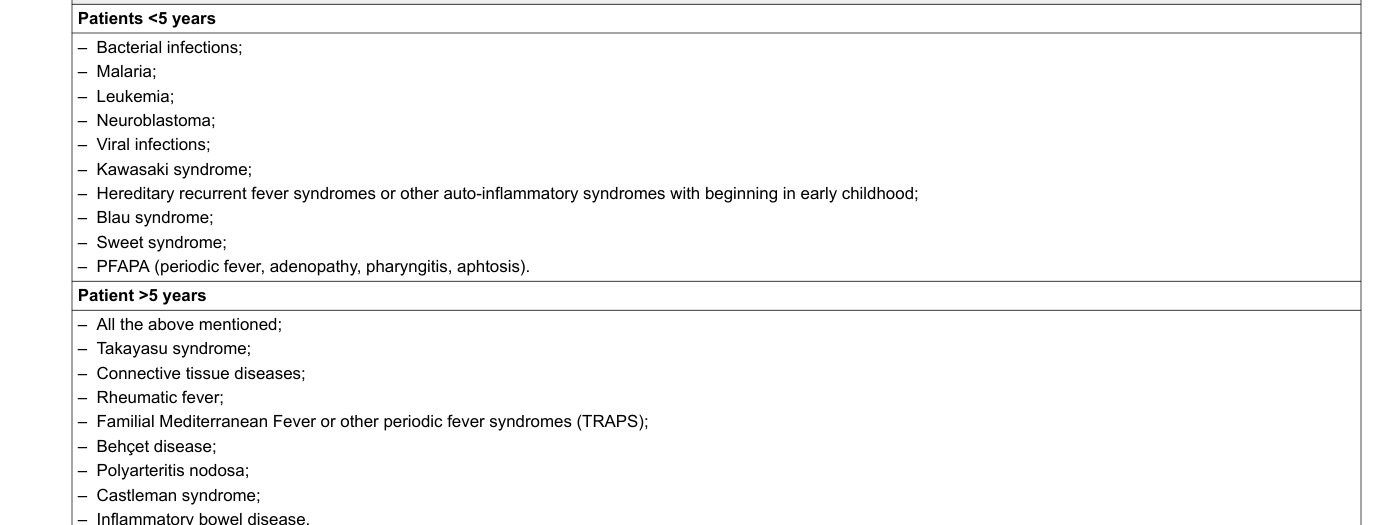
Table 2: Differential diagnosis of SoJIA. Patients <5